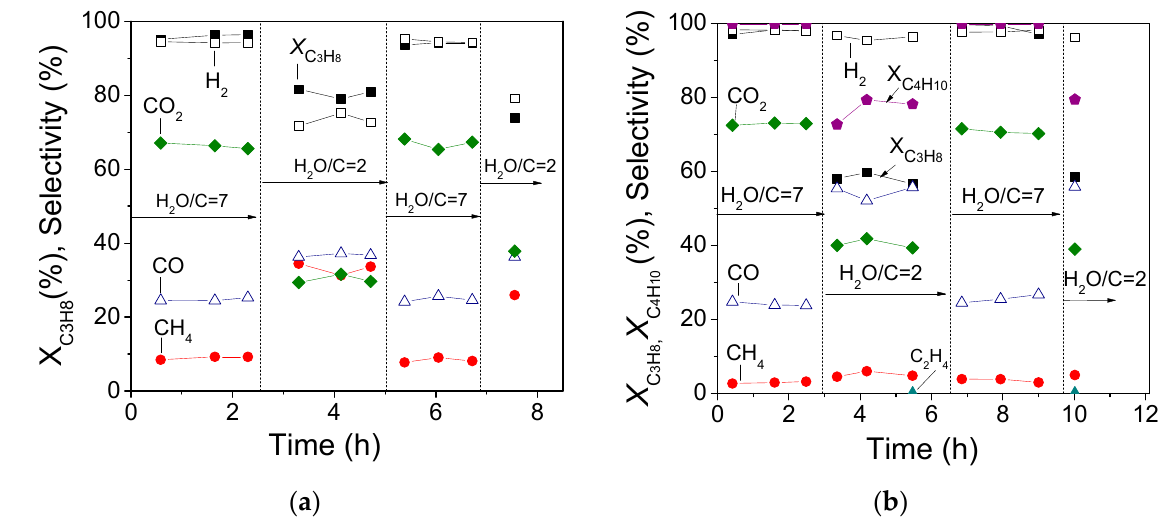
Figure 9. Dynamic response of Rh/TiO 2 catalyst to variations of H 2 O/C ratio obtained ( a ) at 550 °C under conditions of C 3 H 8 steam reforming and ( b ) at 600 °C under conditions of C 3 H 8 /C 4 H 10 steam reforming. GHSV = 55,900 h − 1 .